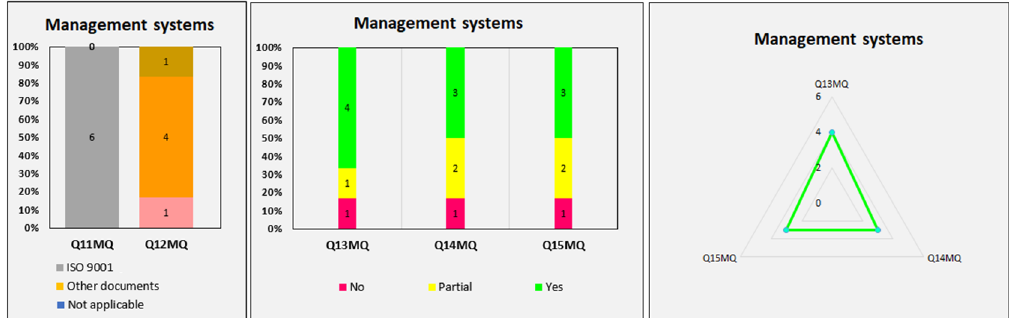
Figure 11. Answers regarding the management systems criteria.